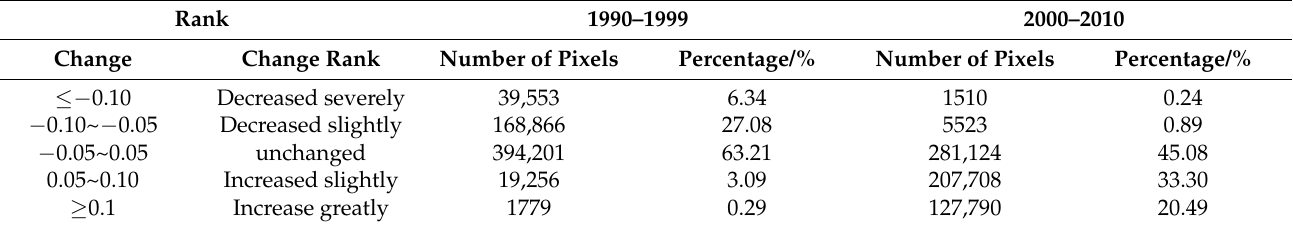
Figure 9. NDVI difference map on the Loess Plateau before ( a ) and after the implementation of ecological engineering ( b ). Table 8. Changes in the NDVI before and after ecological engineering on the Loess